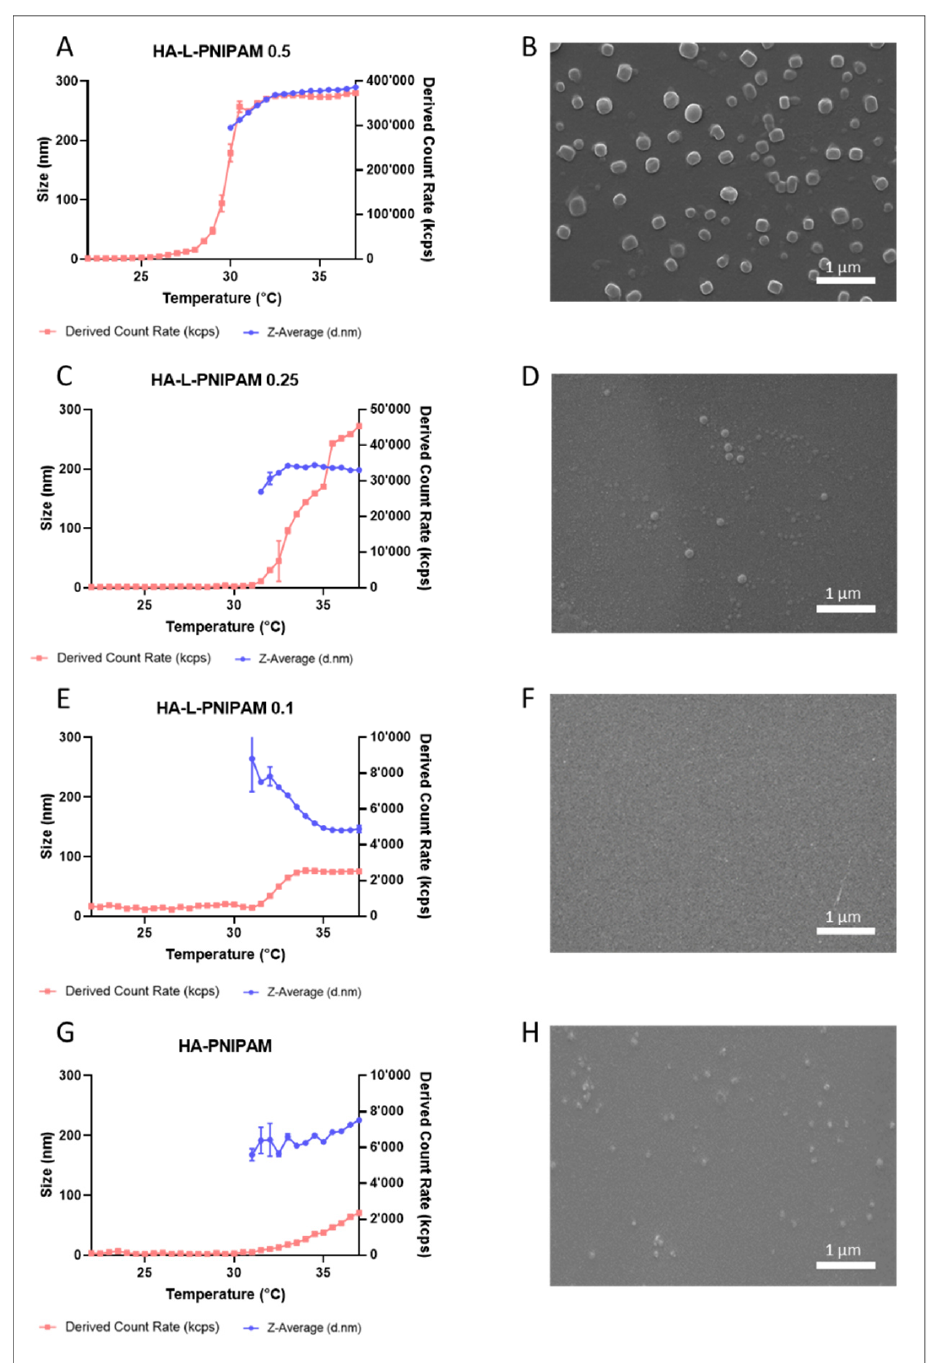
Figure 2. Formation process of nanoparticles upon heating for HA-L-PNIPAM 0.5 (PDI from 0.273 to 0.011) ( A ), HA-L-PNIPAM 0.25 (PDI from 0.464 to 0.212) ( C ), HA-L-PNIPAM 0.1 (PDI from 0.265 to 0.169) ( E ) and HA-PNIPAM (PDI from 0.276 to 0.008) ( G ). Their size and the derived count rate are presented as a function of temperature ( n = 3; ± sd). Scanning electron micrograph of HA-L- PNIPAM 0.5 ( B ), HA-L-PNIPAM 0.25 ( D ), HA-L-PNIPAM 0.1 ( F ) and HA-PNIPAM ( H ) of samples. Scale bar = 1 µ m. Magnification 20,000 × . Voltage = 15.0 kV. Concentrations 0.001% w/v